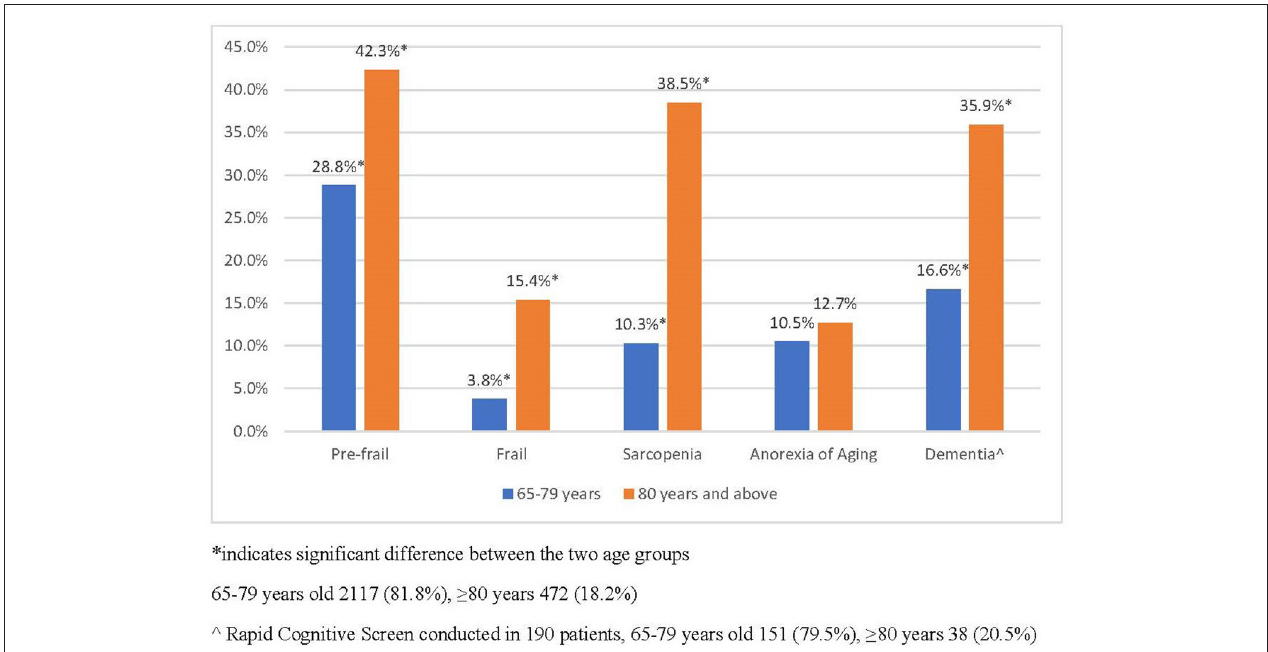
FIGURE 3 | Prevalence of geriatric syndromes in the old and old–old in primary care. *indicated significant between the two age groups. 65–79 years old 2,117 (81.8%), ≥ 80 years 472 (18.2%). ∧ Rapid cognitive screen conducted in 190 patients, 65–79 years old 151 (79.5%), ≥ 80 years 38 (20.5%).